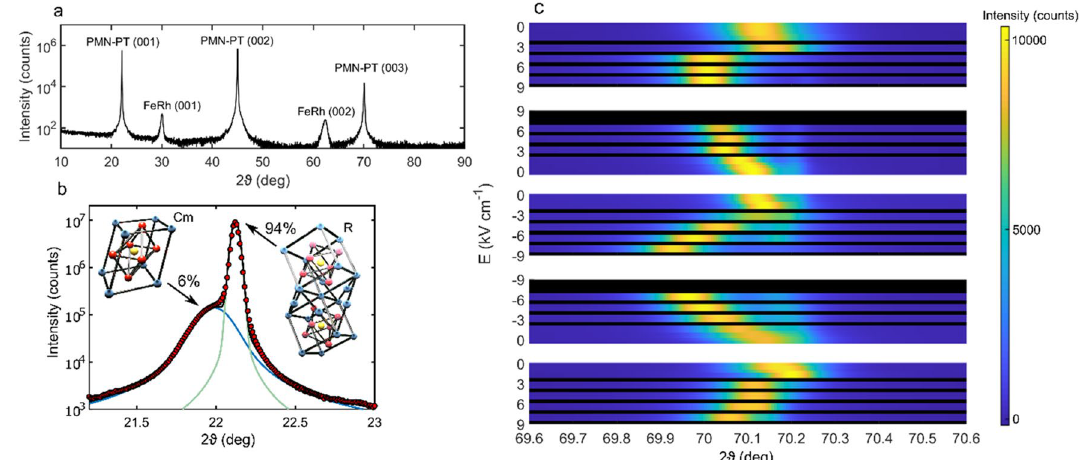
Figure 1. ( a ) XRD data for a ∼ 20 nm FeRh thin film fabricated onto an [001]-oriented PMN 28 -PT 72 single crystal substrate. The presence of FeRh (001) and (002) diffraction peaks demonstrates the presence of B2-ordered FeRh. ( b ) XRD data taken about the PMN-PT (001) diffraction peak. A duel-peak diffraction is observed, with contributions from the rhombohedral and cubic monoclinic phases of PMN-PT. ( c ) XRD data about the PMN-PT (003) diffraction peak as a function of applied electric field E . The data show that increasingly positive or negative electric fields shift the diffraction peak towards lower ϑ, while changes in the applied field towards zero shift the peak towards larger